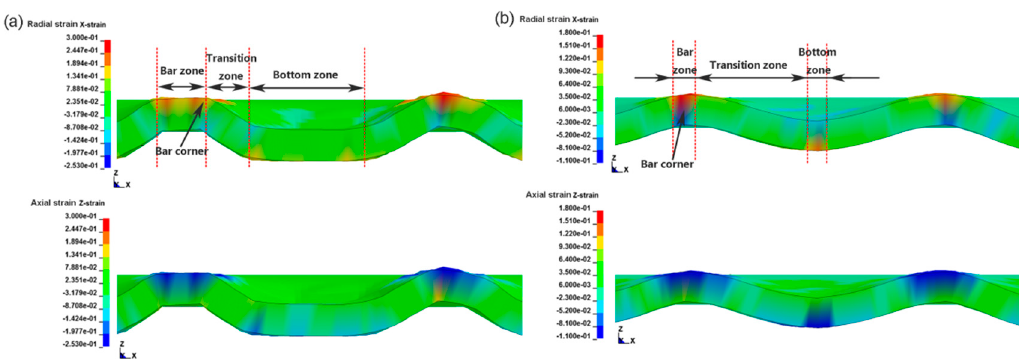
Figure 30. Plastic strain distribution of embossed microchannel with the thickness of 30 μ m: ( a ) under the laser energy of 1800 mJ and ( b ) under the laser energy of 565 mJ.